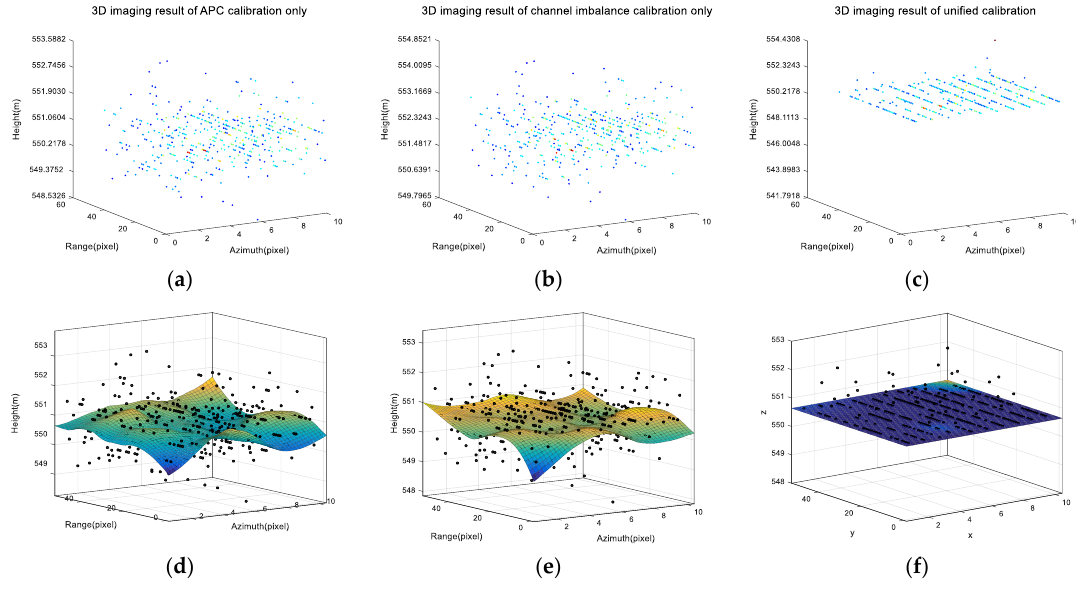
Figure 11. 3D imaging results of the selected flat ground. ( a – c ) 3D imaging results of the flat ground obtained by utilizing APC calibration only, channel imbalance calibration only, and a unified calibration algorithm, respectively. ( d – f ) The surface fitting results of (a–c), respectively.